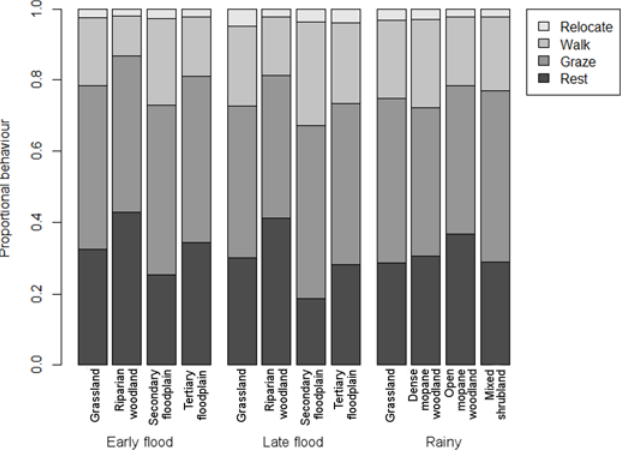
Fig 3. Seasonal variation in behaviour between seasonally-preferred